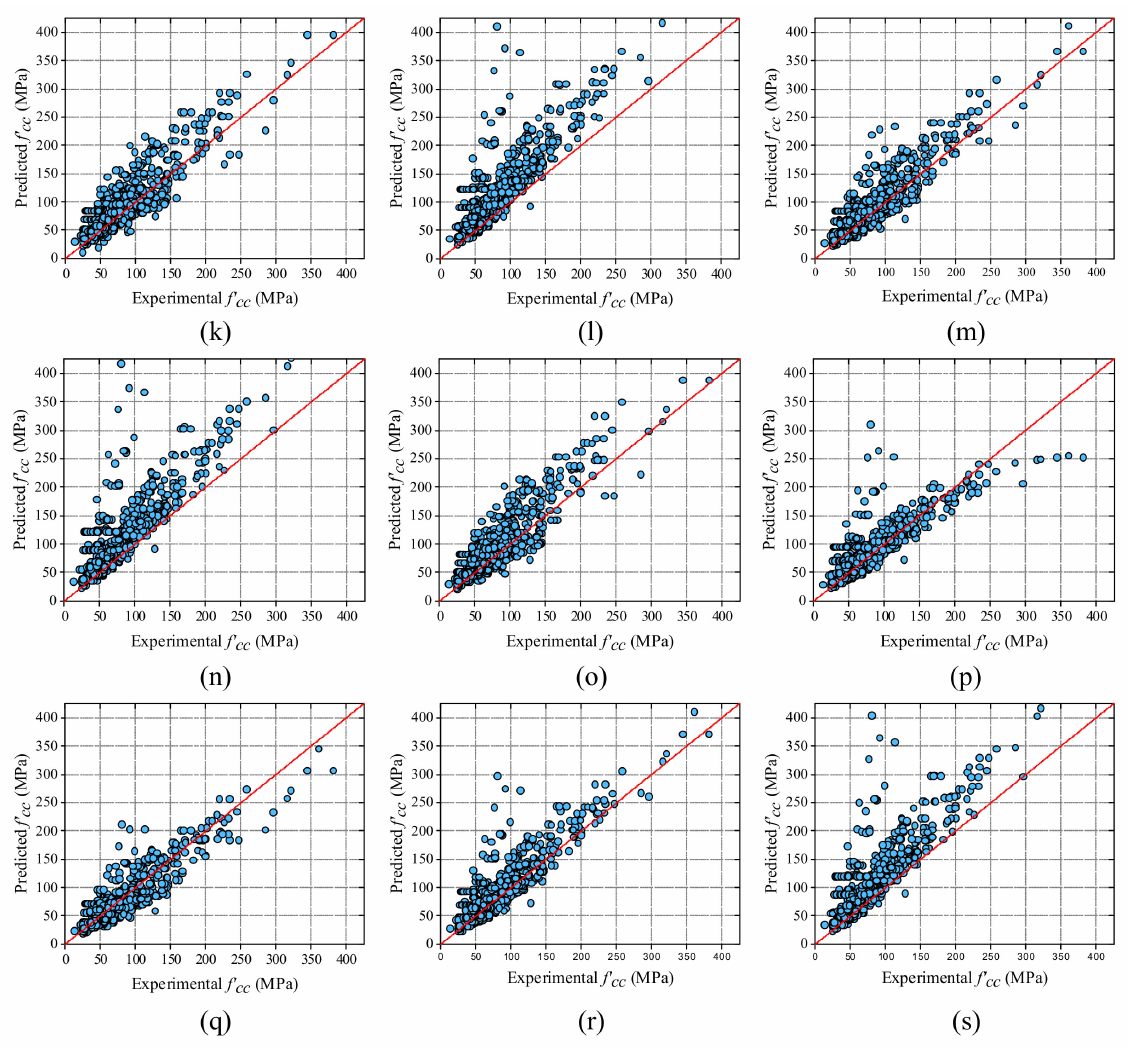
Figure 7. Scatter plot of analytical models; ( a ) Wu and Wei [92], ( b ) Pham and Hadi